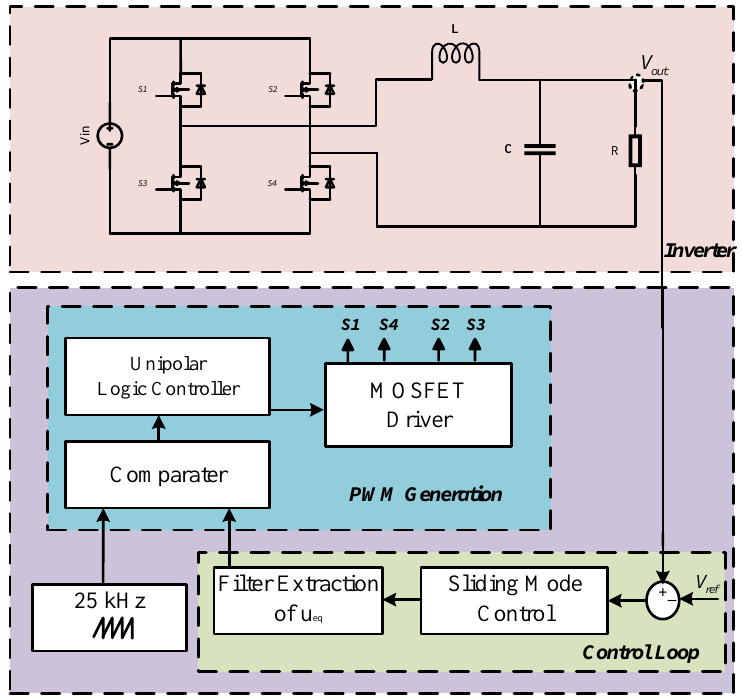
Figure 1. Block diagram representation of proposed SM